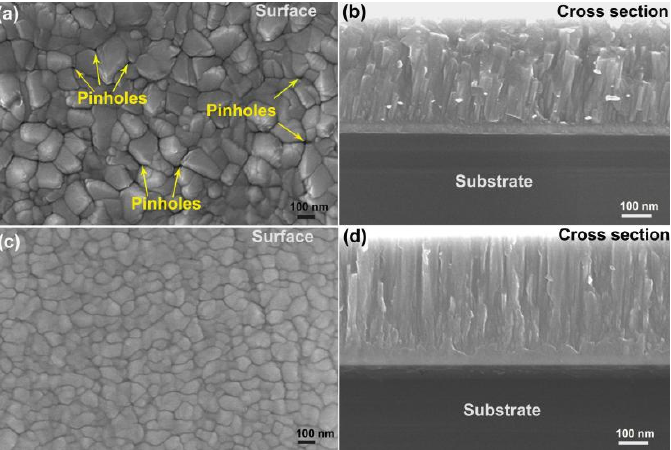
Figure 4. SEM images of the as-deposited coatings: ( a ) and ( b ) CrN, ( c ) and ( d ) CrN–Pt.